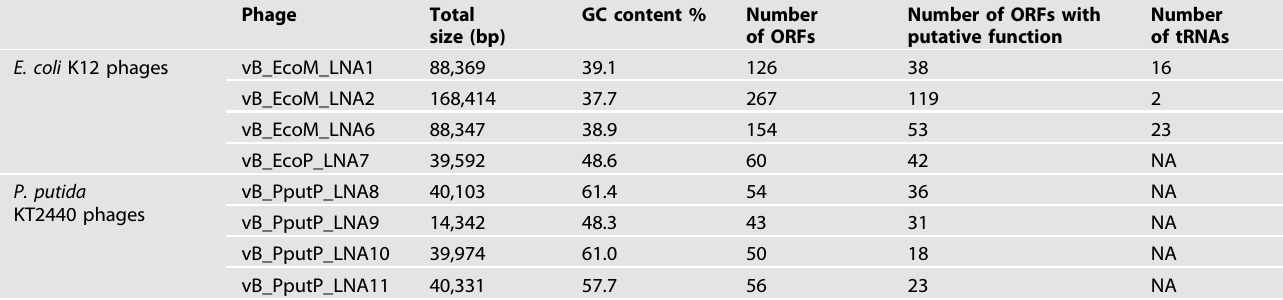
Table 2. Summary of genomic features of E. coli K12 and P. putida KT2440